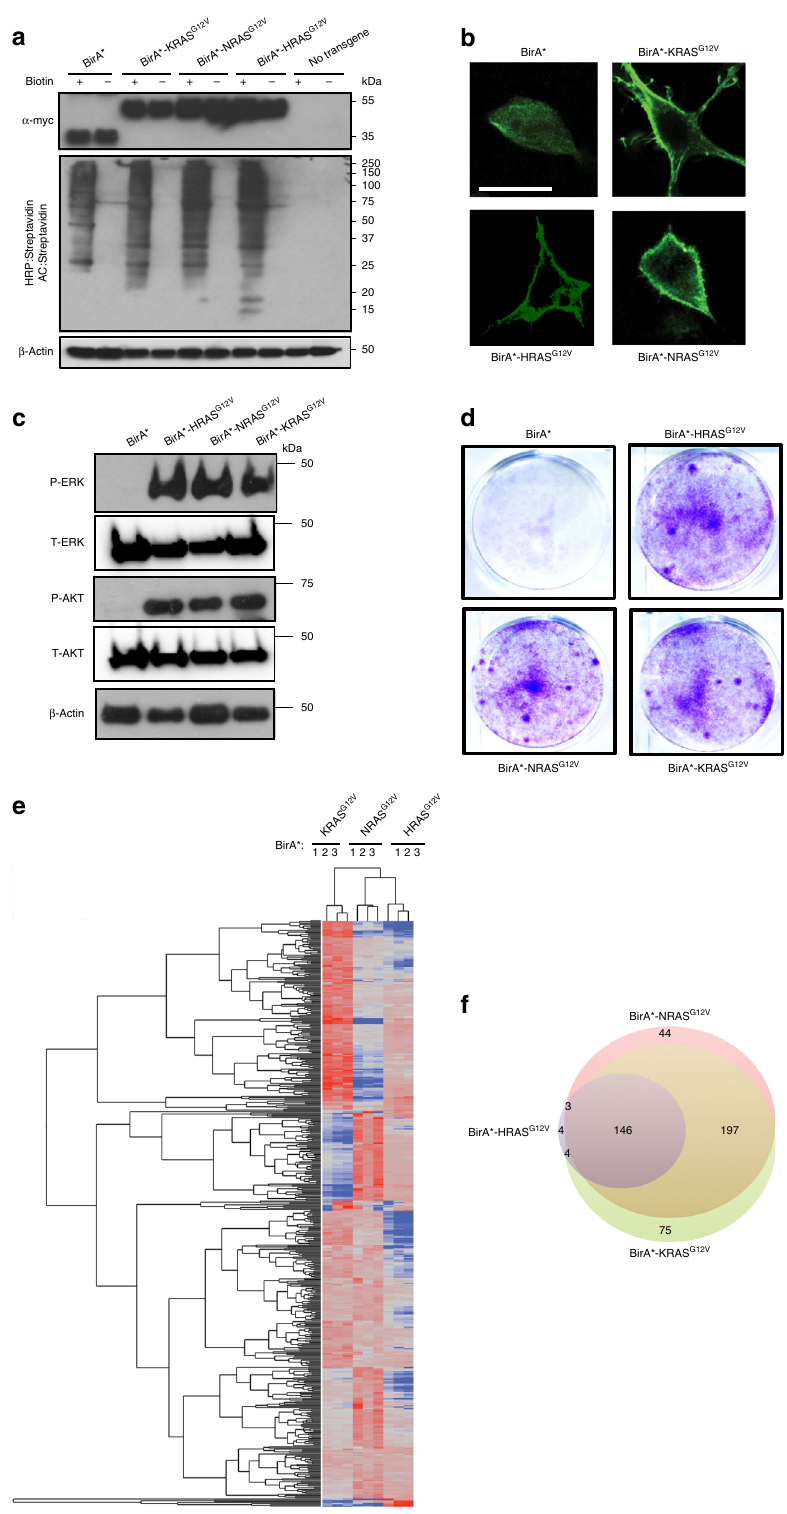
Fig. 1 BioID identi fi es RAS interactomes. a Immunoblot detection of myc-tagged BirA* alone or fused to the indicated RAS G12V isoforms (top) and biotinylated proteins with HRP-streptavidin after af fi nity capture (AC) with streptavidin-conjugated beads (middle) in the absence ( − ) and presence ( + ) of biotin. Empty vector-transduced cells (bottom) serve as a negative control. n = 2. b Representative images indicated myc-tagged BirA* alone or fused to the indicated RAS G12V isoforms, as visualized by fl uorescence microscopy. Scale bar: 5 μ M. n = 1. c Immunoblot detection of total (T-) and phosphorylated (P-) ERK and AKT and d Crystal Violet staining of cells stably expressing myc-tagged BirA* alone or fused to the indicated RAS G12V isoforms. n = 2. e Hierarchical clustering of the z -scores derived from degree that the 477 interactome proteins were labeled by the indicated myc-tagged BirA*-RAS G12V proteins in triplicate cultures. f Venn diagram of the number of interactome proteins identi fi ed by BioID by the indicated BirA*-RAS G12V proteins. Where indicated, β -actin serves as a loading